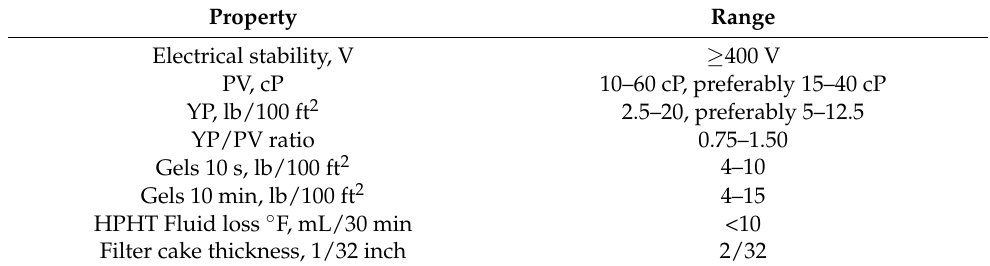
Table 1 summaries the main recommended rheological and fluids loss properties of OBDF. Table 1. Recommended range of rheological and fluid loss properties for OBDF